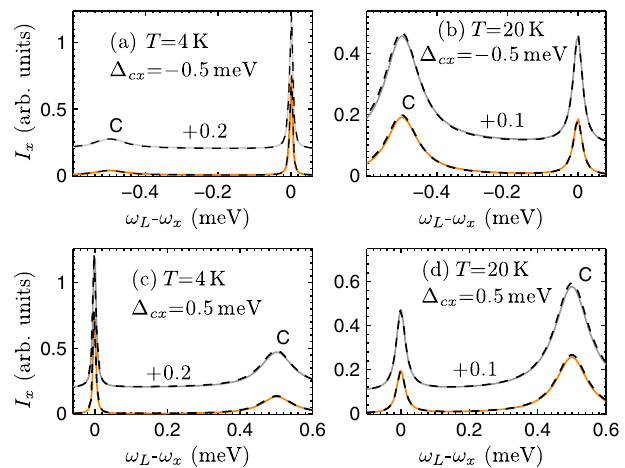
TABLE II. Dependence on the x=c FWHM of the power- FIG. 7. (a)-(b) Relative QD intensity for a cavity-driven sys- broadened line shape on (cid:10) , for a QD-driven cavity-measured ¼ (cid:1) 0 : 5 meV ¼ 3 meV ), and a for cavity-driven tem as a function of QD-laser detuning for (cid:1) system ( x FWHM, with (cid:1) cx cx and phonon-bath temperatures (a) T ¼ 4 K and (b) T ¼ 20 K , QD-cavity parameters are the same as in Table I, and all units and for two different values of the cw laser Rabi frequency ¼ 40 (cid:8) eV , and grey, lower, are in (cid:8) eV . (orange solid line corresponds to (cid:4) c ¼ 60 (cid:8) eV ). Also shown (black solid line corresponds to (cid:4) c dashed curves) is the PL intensity obtained using the effective Lindblad form of the full time-convolutionless ME. The parame- ters are as follows: (cid:7) ¼ 2 (cid:8) eV , (cid:10) ¼ 50 (cid:8) eV , (cid:7) 0 ¼ 2 (cid:8) eV at T ¼ 4 K , and (cid:7) 0 ¼ 20 (cid:8) eV at T ¼ 20 K . (c)-(d) Same as in (a) ¼ 0 : 5 meV . and (b) but with (cid:1) cx